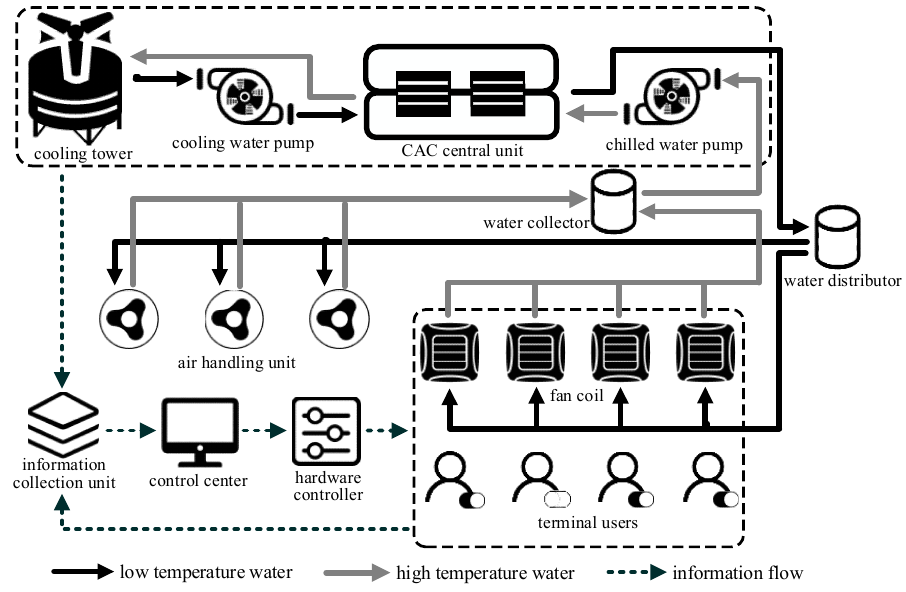
Figure 3. The working principle and basic application settings of CAC.